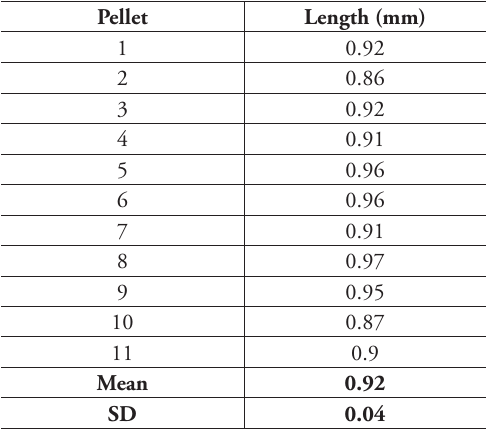
Table S1. Size of pellet of P. macondianus sp.